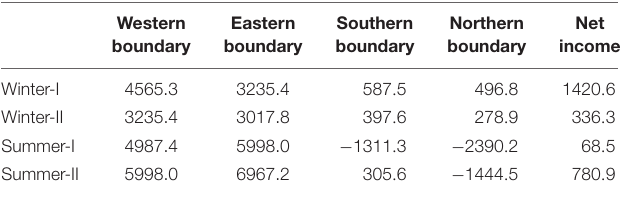
TABLE 3 | Annual mean flux of water vapor transport for every boundary and the net income in regions I and II in winter and summer from 1979 to 2017 (units: × 10 8 t a − 1